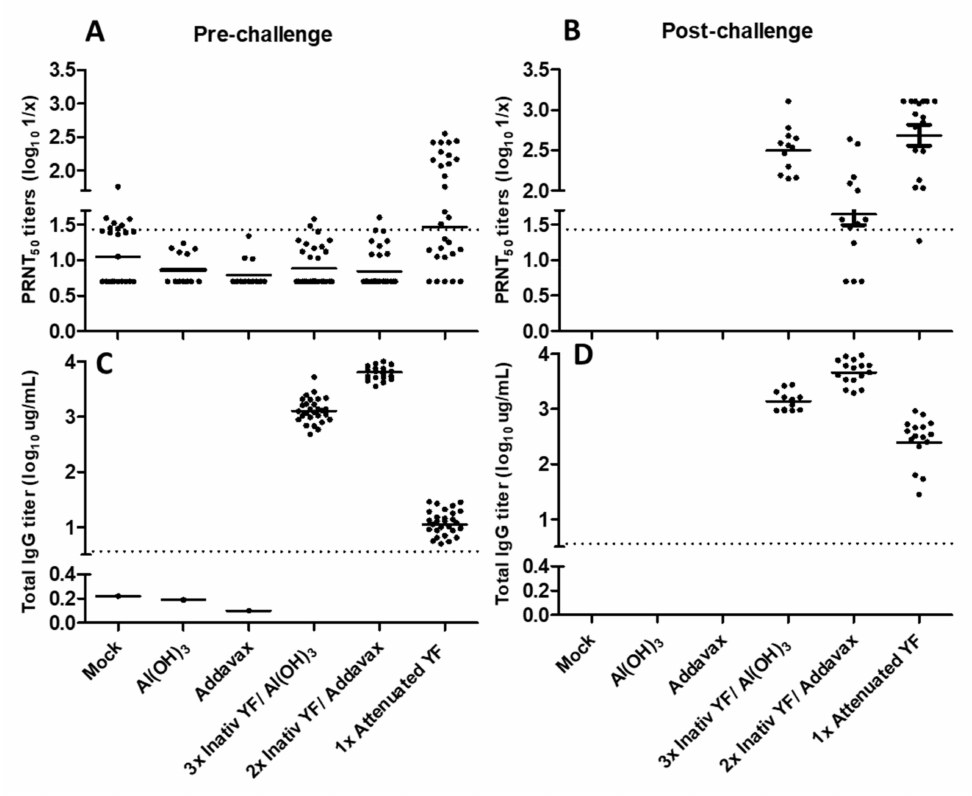
Figure 1. Immunogenicity of different inactivated YF 17DD virus formulations. Neutralizing anti- bodies titers in pre-( A ) and post-challenge ( B ) times. Total IgG titers in pre-( C ) and post-challenge ( D ) times. Data considering PRNT 50 cut off = 1,43 and ELISA IgG cut off = 0.56. Animals from negative control groups died after the challenge, so their post-challenge antibody titers were not measured. ( A ): non normal data; p < 0.0001 by Kruskal–Wallis test. ( B – D ) all groups presented normal data; p < 0.0001 by one-way